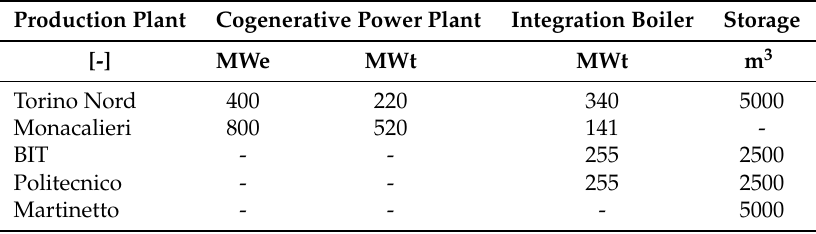
Table 1. Main parameters of Turin DH system. Reproduced from [26,29], AIRU 2018. Production